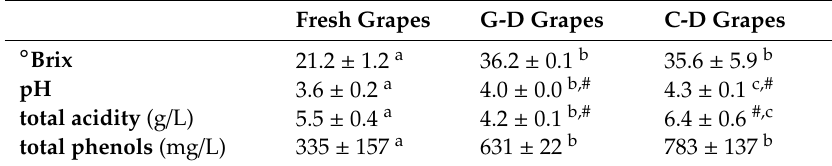
Table 1. Basic parameters of juices from ‘Maraština’ fresh grapes, greenhouse-dried (G-D) grapes, and chamber-dried (C-D) grapes at 50 ◦ C (average ± standard